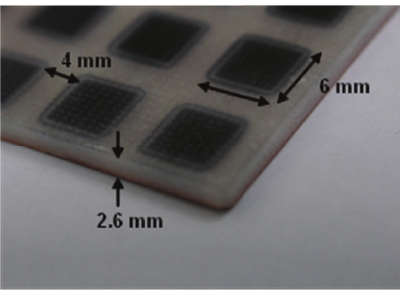
Figure 6: Free-space measurement system.